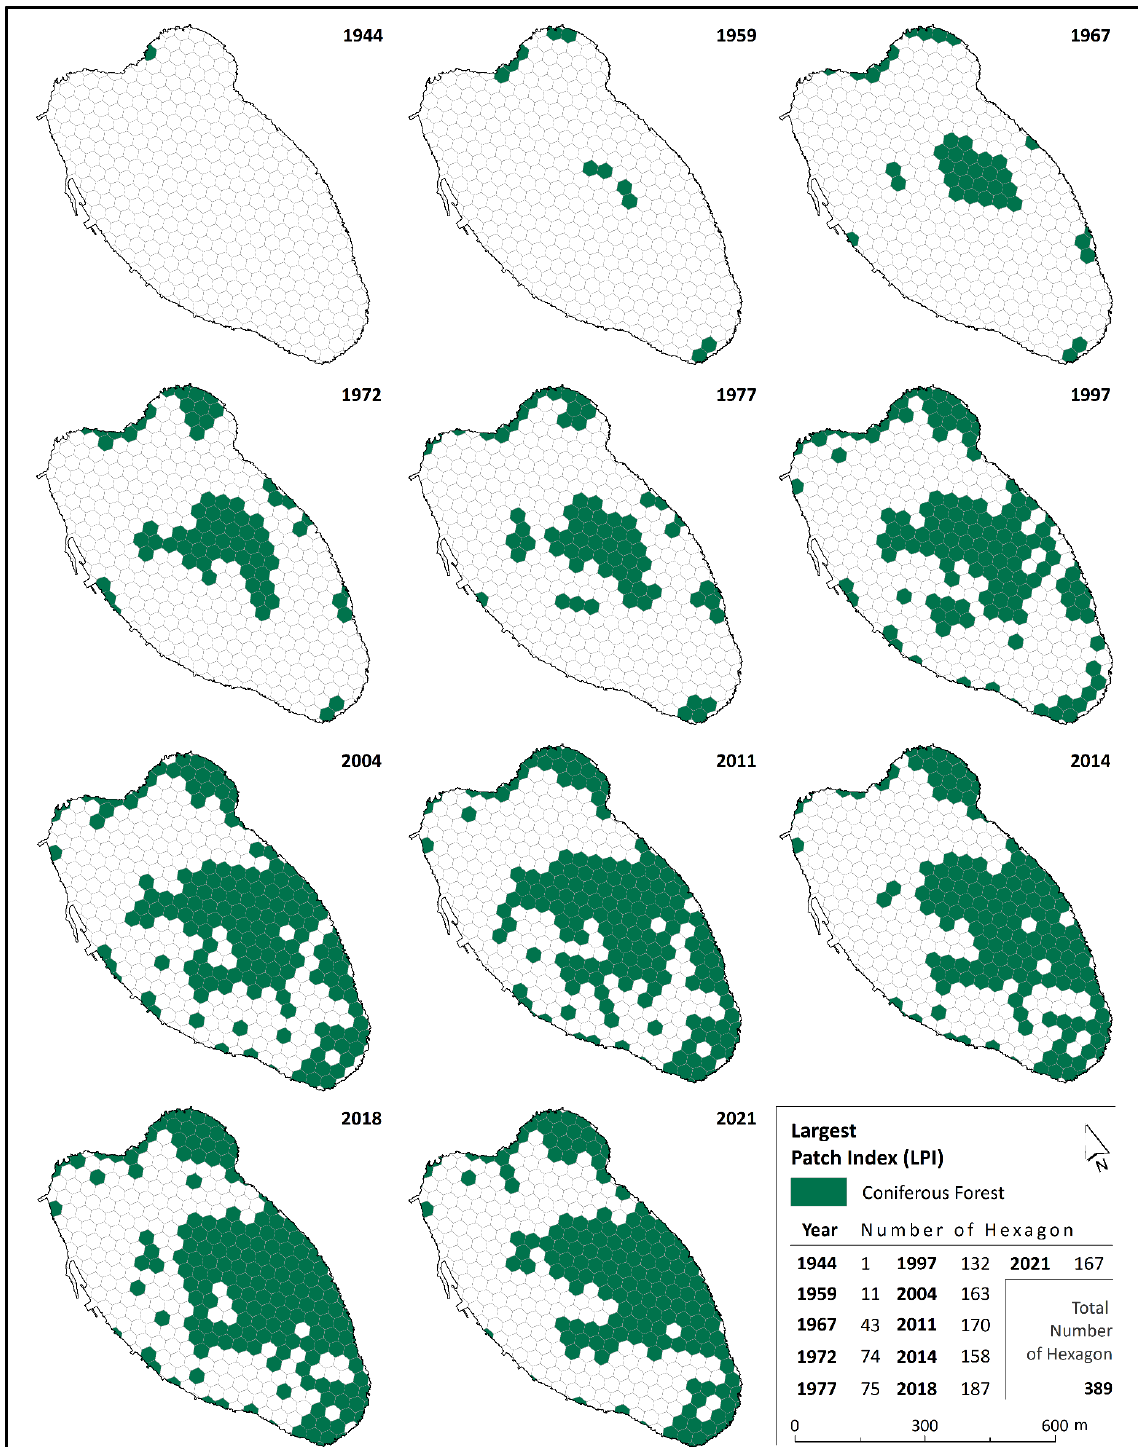
Figure 17. LPI per zones for Ošljak (1944—2021).